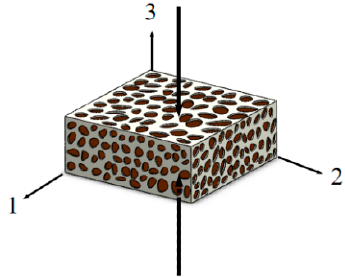
Figure 4. Stress diagram.